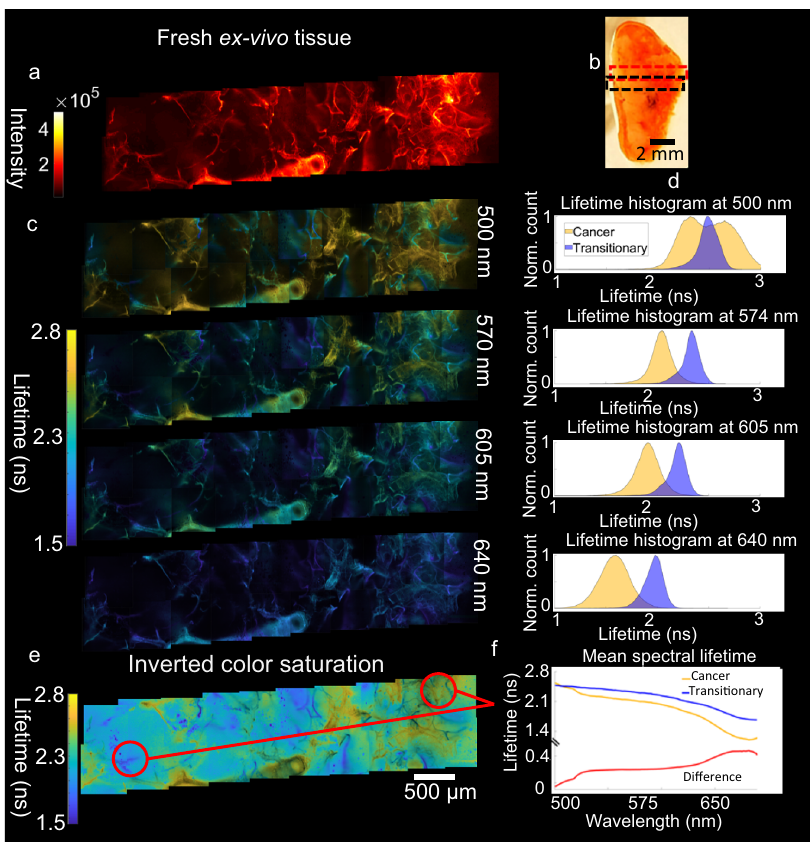
Fig. 5 Full spectral lifetime imaging of a fresh, ex-vivo lung tissue sample. a Intensity based image of the fresh ex-vivo tissue sample from the same surface used to gather histology slices (Fig. 4) with increasing structural detail from left (cancer) to right. b An image of the tissue sample as measured, with the dashed box indicating the section of the sample from which imaging was acquired (2 × 10 images at 256 × 256 pixels and ~600 × 600 µ m covering an area of ~6 × 1 mm). c A series of lifetime images taken from the FS-FLIM data cube at various wavelengths showing the progression of lifetime through the cube. d Normalized (Norm.) lifetime histograms corresponding to two regions of interest, cancerous and transitional, for the wavelengths shown in c . e A set of images from 570 nm with an inverted transparency channel, highlighting cancerous regions. f Mean spectral lifetime from the equivalent regions of interest shown (cancer, left, transitionary region, right) along with the difference between them. Due to the constraint of sample availability the fresh tissue sample was imaged once for each data cube location, and consistency across the 20 images shows repeatability of the technique. Note: this publication does not aim to show the cross-sample signi fi cance of the lifetimes